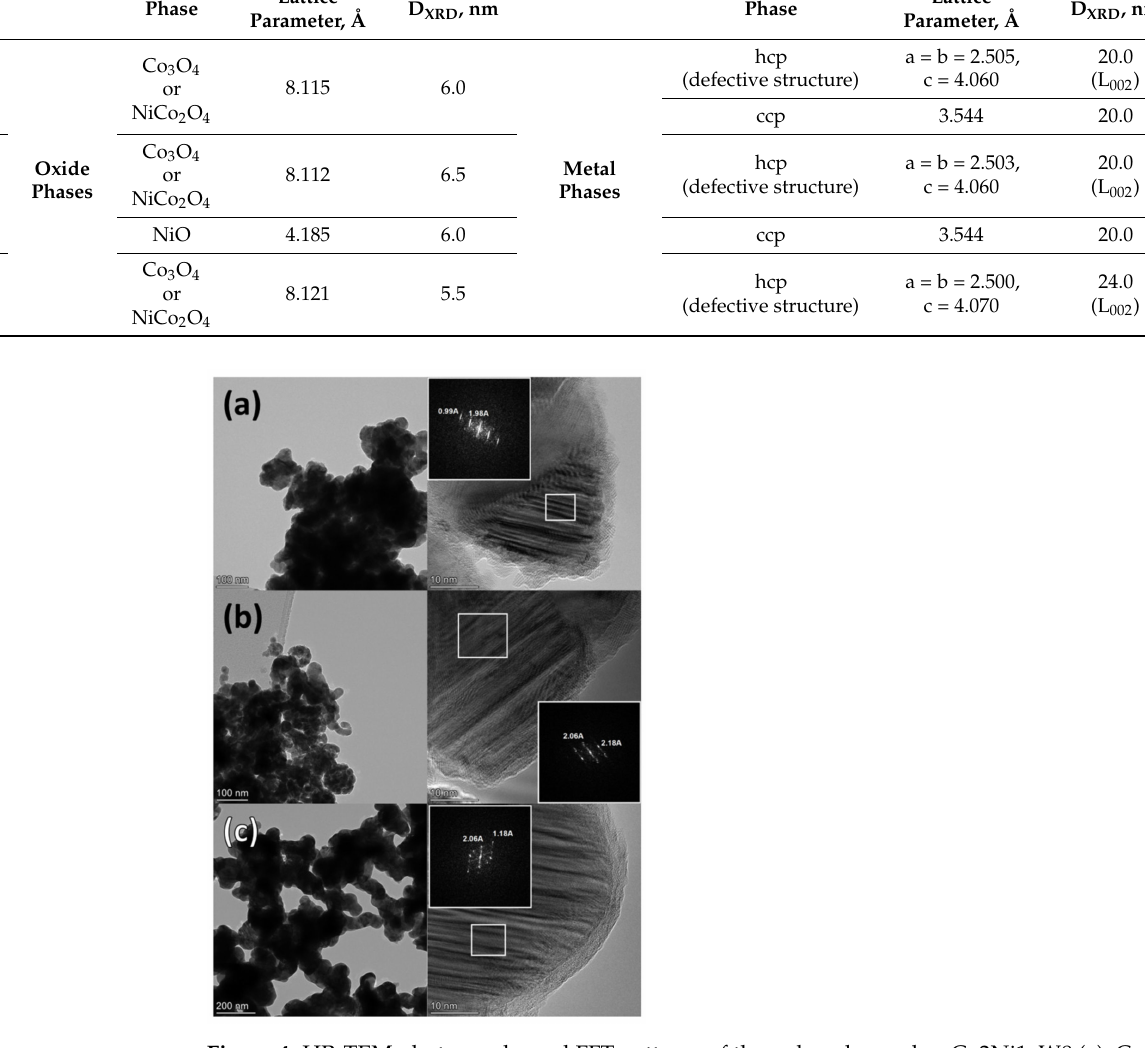
Figure 4. HR-TEM photographs and FFT patterns of the reduced samples: Co2Ni1_W8 ( a ); Co_W8 ( b ); Co2Ni1_W0 ( c